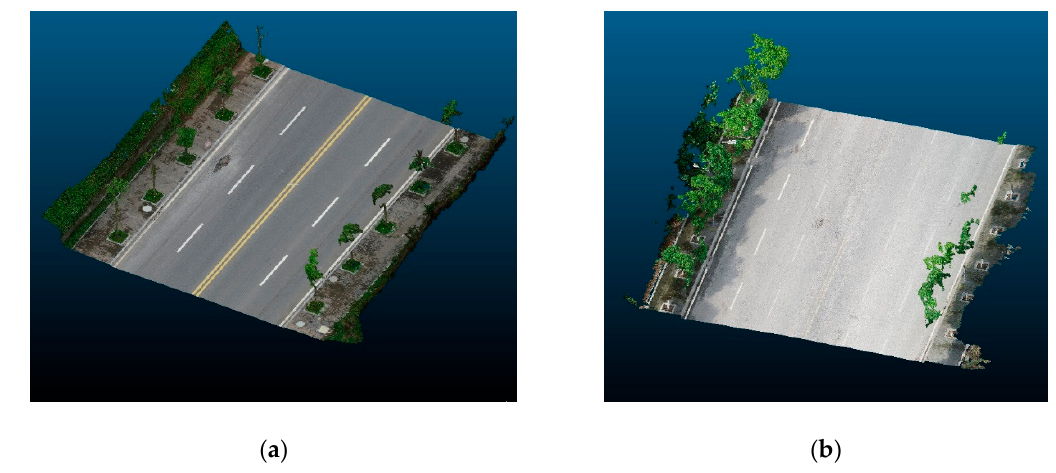
Figure 2. Overview flow chart.